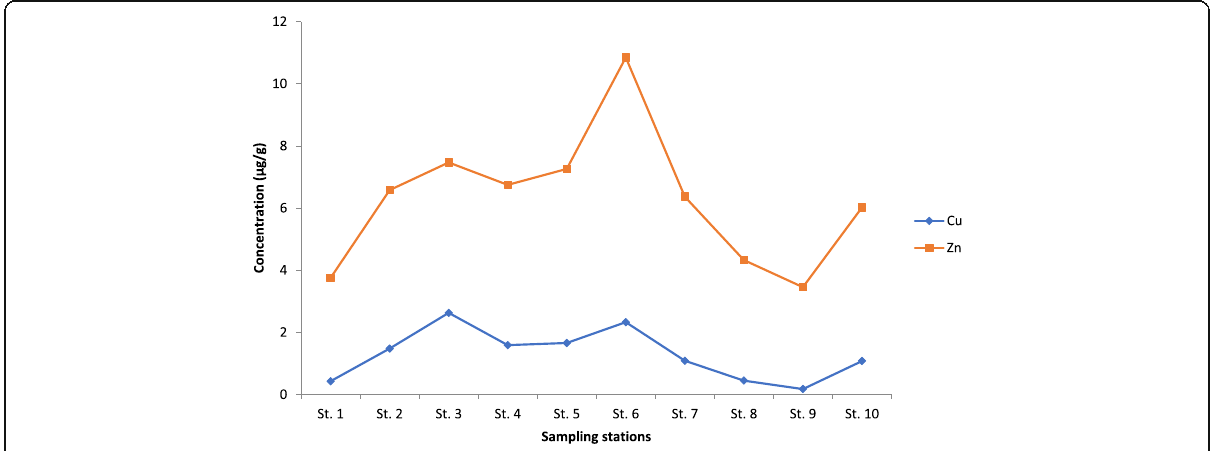
Fig. 2 Concentrations of Cu and Zn in the sediments of River Osun, Osogbo, Nigeria (June 2015 – March